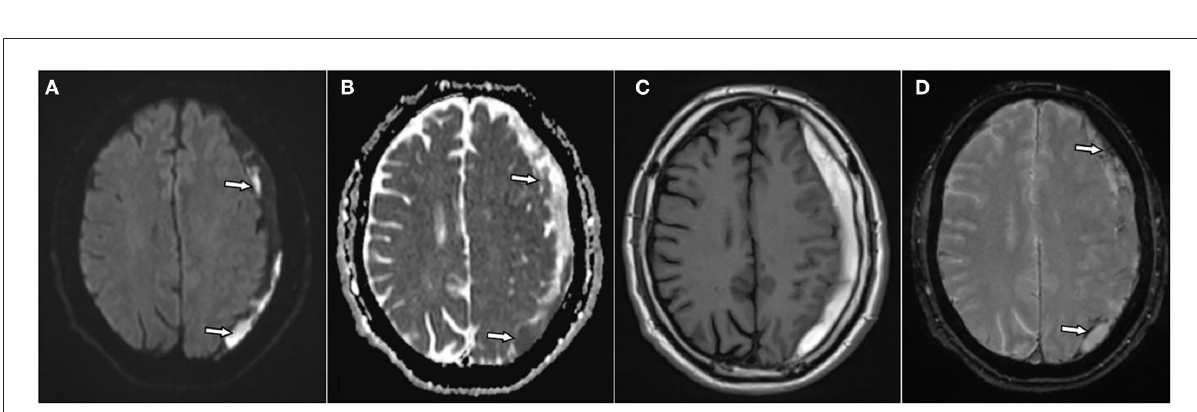
FIGURE2 A 66-year-old male patient with chronic subdural hematoma (cSDH) over the left convexity. Axial diffusion-weighted image (DWI) (A) and respective apparent diffusion coefficient (ADC) map (B) , T1w image (C) , and T2 * gradient echo-weighted image (D) . There are patchy areas of diffusion restriction within the hematoma [ (A,B) : arrows]. The hematoma is homogenously hyperintense on T1w images (C) and shows hemosiderin staining adjacent to the inner membrane and septa [ (D) : arrows] on T2 *